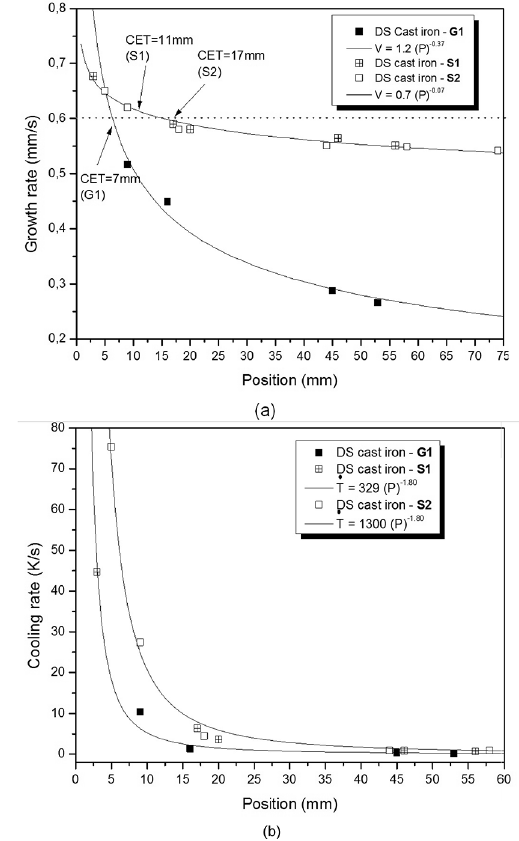
Figure 3: (a) Growth rate and (b) Cooling rate as a function of position from the cooled surface of the DS cast iron.